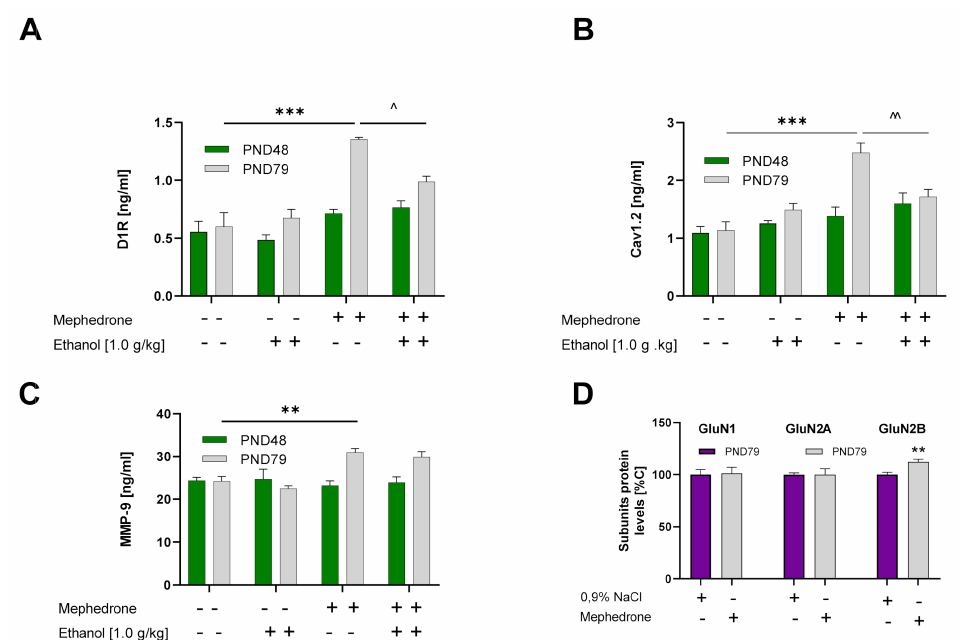
Figure 2. Effect of mephedrone (3 × 10 mg/kg/day, PND30-36, n = 6/group) pretreatment and ethanol (1.0 g/kg) treatment on: ( A ) D1R protein expression; *** p < 0.001 vs. 0.9% NaCl/0.9% NaCl%, PND79; ˆ p < 0.05 vs. mephedrone/EtOH 1.0 g/kg, PND79. ( B ) Cav1.2 protein expression; *** p < 0.001 vs. 0.9% NaCl/0.9% NaCl%, PND79; ˆˆ p < 0.01 vs. mephedrone/EtOH 1.0 g/kg, PND79, ( C ) MMP-9 protein expression; ** p < 0.01 vs. 0.9% NaCl/0.9% NaCl%, PND79; in the vSTR of adolescent (PND48) and adult (PND79) rats. ( D ) Effect of mephedrone (3 × 10 mg/kg/day, PND30-36, n = 8/group) on expression of NMDA receptor subunits in vSTR of adult (PND79) rats; ** p < 0.01 vs. 0.9% NaCl. Corresponding membranes from Western blot analyses of NMDA receptor subunits and loading controls are included into Figure